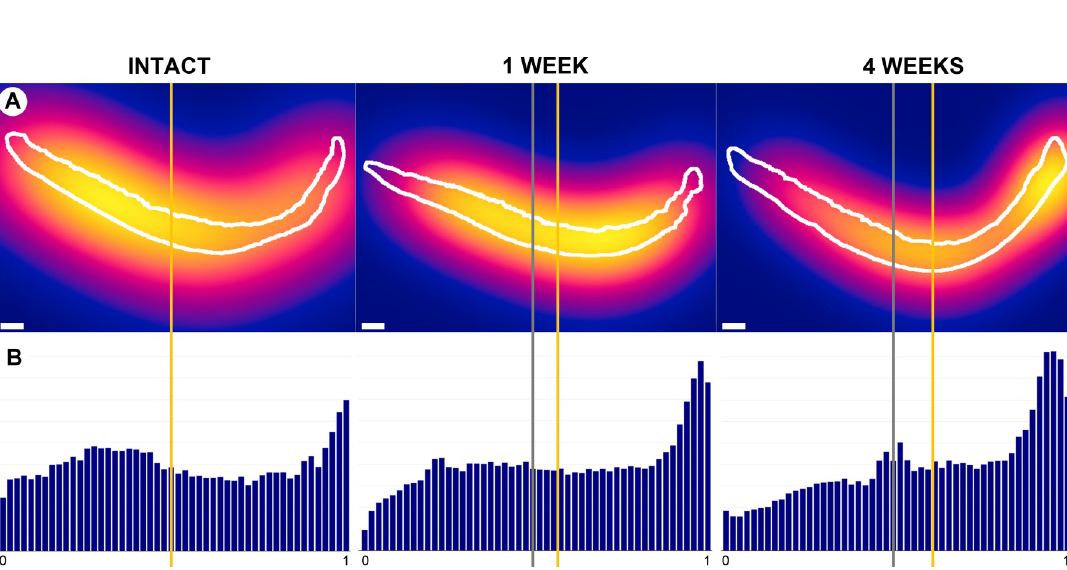
Fig 7. Medial femoral condyle articular cartilage demonstrates a shift in cell distribution away from areas articulating with the tibial spine at 1- and 4 weeks following surgical induction of posttraumatic OA. The tibial spine is to the left for each image. (Row A) Heatmaps of chondrocyte cell density, ranging from yellow–highest cell density, to red–intermediate cell density, to dark blue–zero cell density. White bars indicate 1mm. (Row B) Histograms showing the relative frequency of nuclei by relative peripheral position from 0-notch to 1-peripheral. The gray lines indicate the center, and the yellow lines indicate the mean median peripheral chondrocyte position for each specimen. Note the lateral shift of the median cell position over